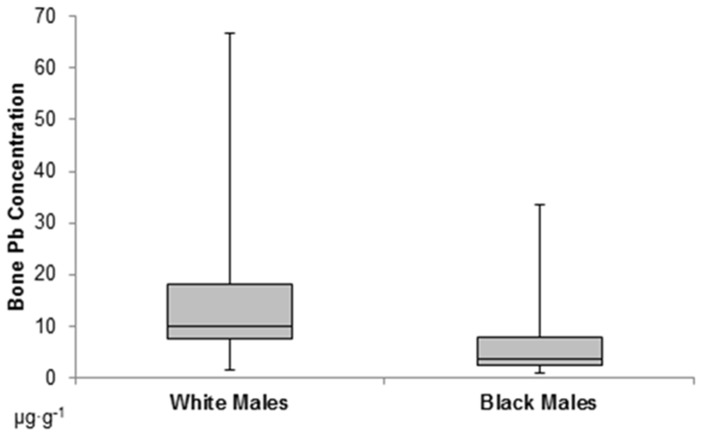
Boxplot of median bone Pb concentrations (in µg·g−1) in black and white males.White males show significantly higher bone Pb concentration than black males. Horizontal line = median, boxes = 2nd and 3rd quartiles, error bars = range.